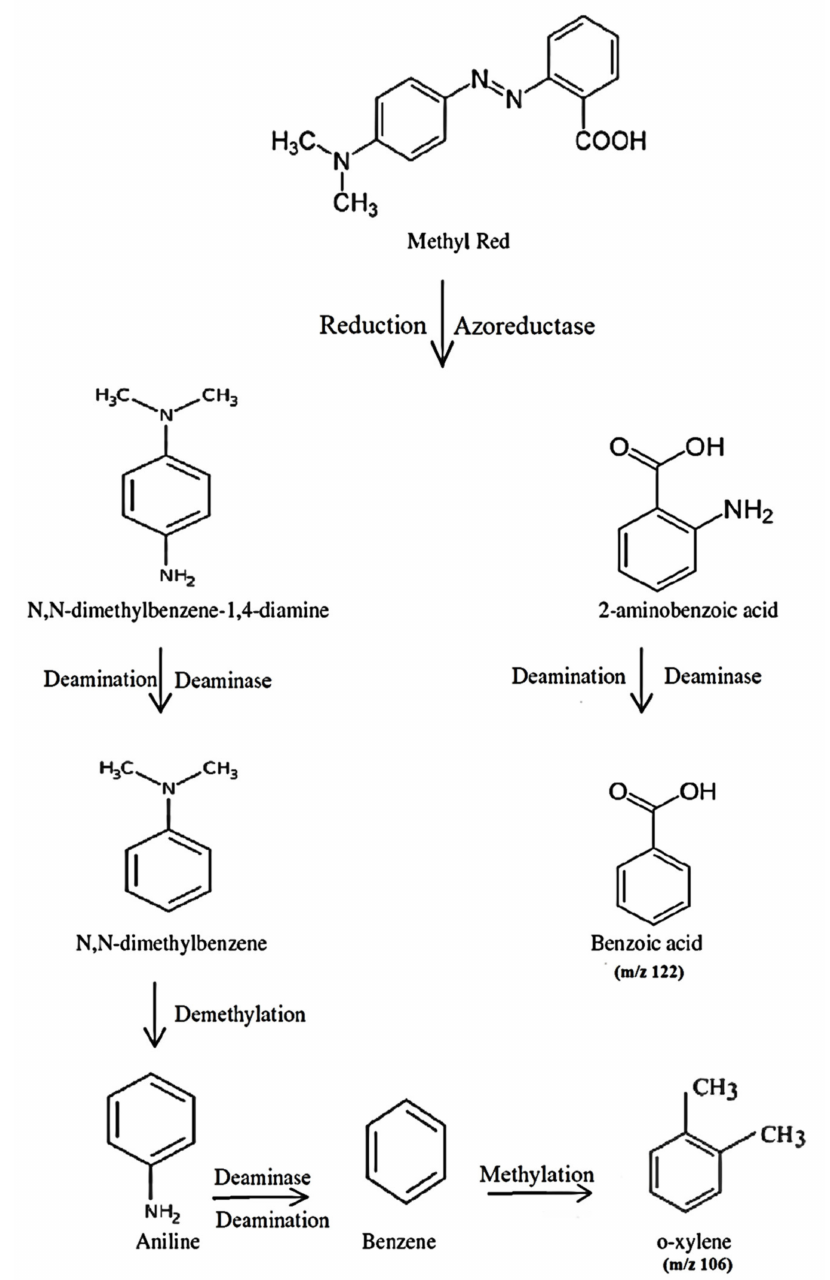
Figure 20. Proposed degradation mechanism of methyl red by P. aeruginosa